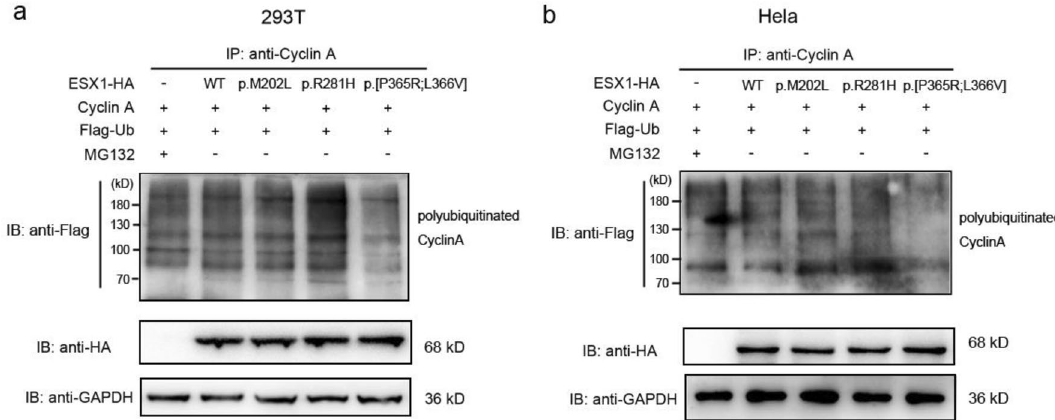
Figure 2. The p.[P365R; L366V] mutation compromised the stabilizing effect of ESX1 on polyubiquitinated cyclin A. Cyclin A and Flag-Ubiquitin were transfected into 293 T ( a ) or Hela ( b ) cells together with wild type or mutant ESX1-HA expression vectors, as indicated. Cells transfected with empty vector of pcDNA 3.1-HA and further treated with MG132 were used as positive control. Cell lysates were then prepared and immunoprecipitated with anti-Cyclin A antibodies. Cyclin A polyubiquitination was detected with anti-Flag antibody. The grouping of blots cropped from different parts of the same gel, or from different gels, fields, or exposures were divided by black lines. Compared with wild type ESX1, polyubiquitination of cyclin A was significantly decreased by the p.[P365R; L366V]